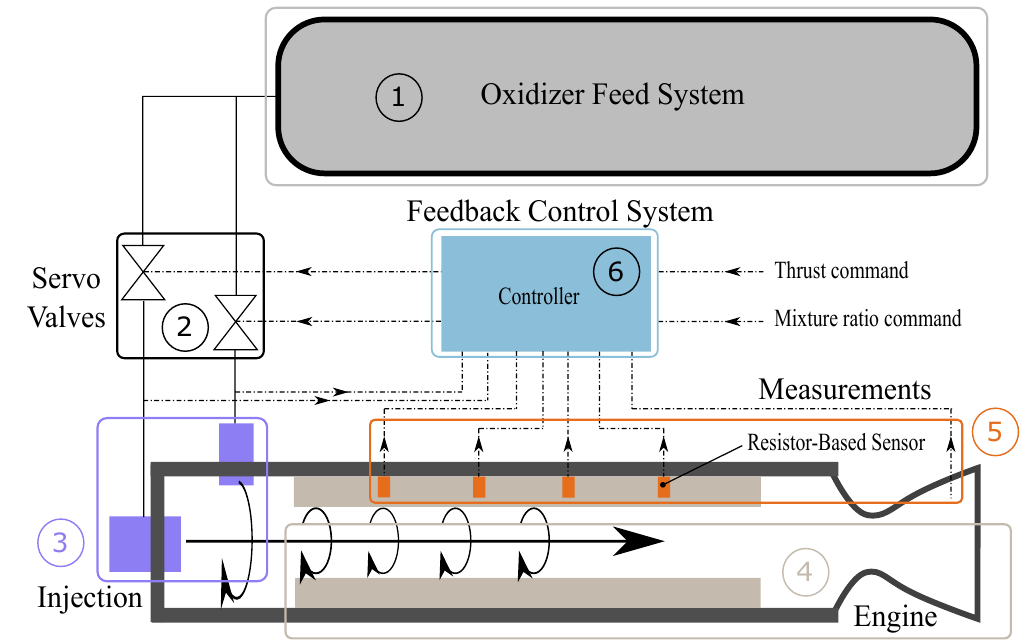
Figure 2. A-SOFT engine simplification for the simulations.